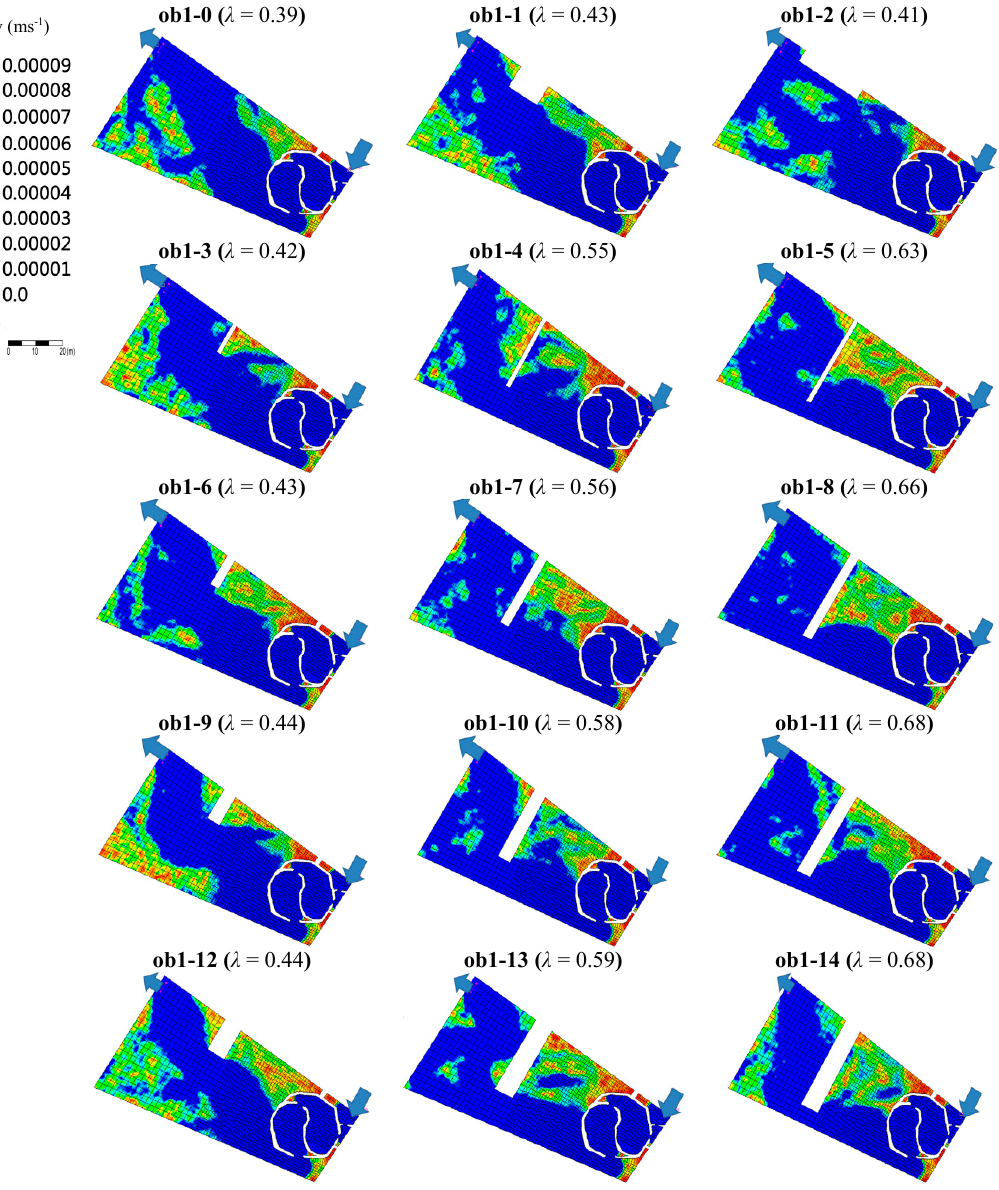
Figure 7. Spatial distribution of the flow velocity in the pond after installing a single baffle with different dimensions in different locations. Case ob1-0 represents the current conditions, and the other cases represent the experimental scenarios. The blue arrows indicate the flow inlet and outlet, whereas the white rectangular bars represent the baffles. The hydraulic efficiency is shown in parentheses according to the name of each